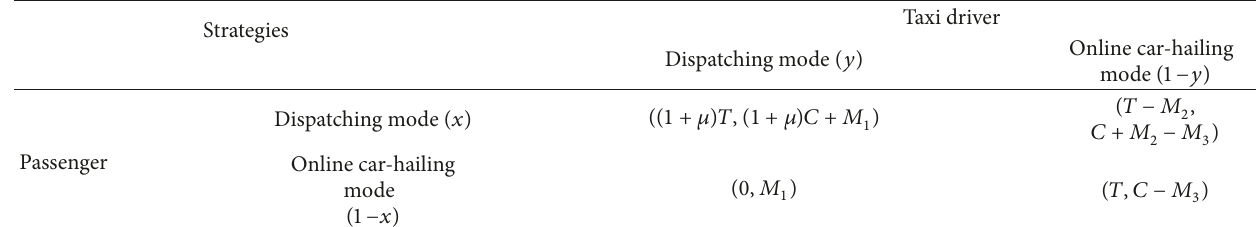
Table 2: Payoff matrix under different decision